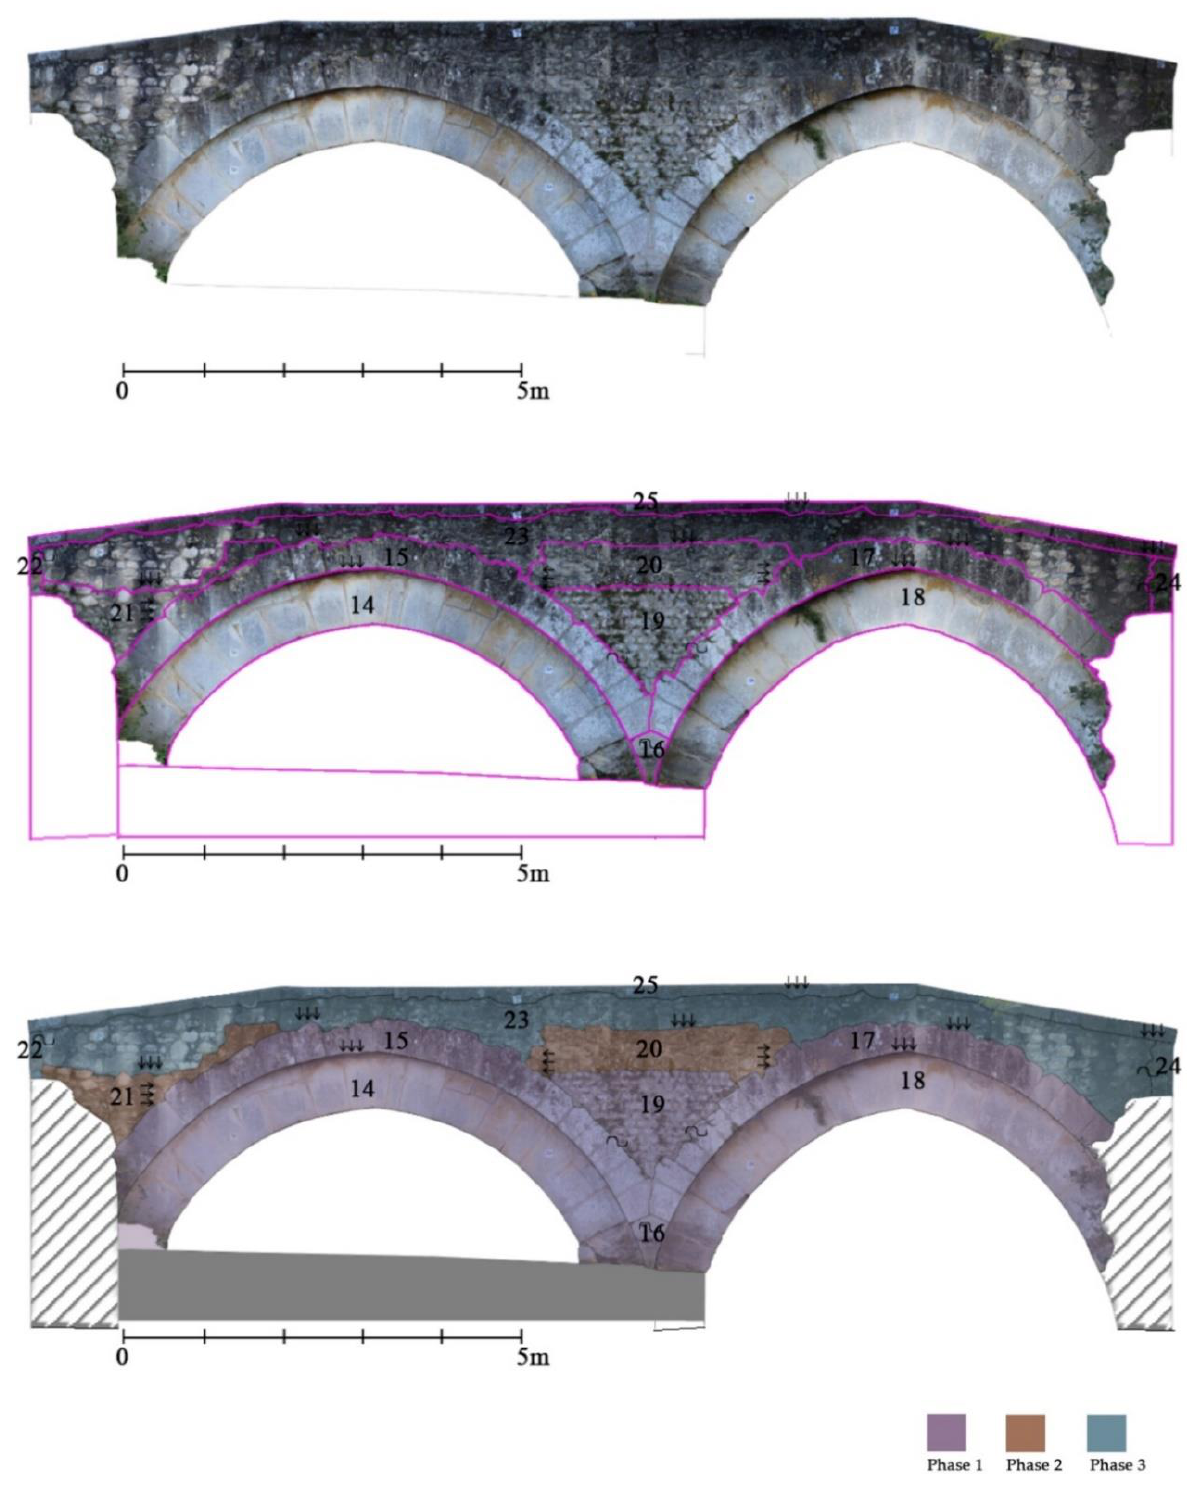
Figure 10. Stratigraphic analysis of the bridge’s northwest front (BB’) in the Cerro locality. The two arches, one round and one pointed, are made with well-squared limestone pieces linked by fine light-colored mortar. On both faces of the bridge the two arches are surmounted by protruding ferrules, resting on the same ashlar that testifies the construction in the same phase. These upper arches are made with stones worked in the exposed face. In phase with this, the clearly detectable revetment can be placed between the two